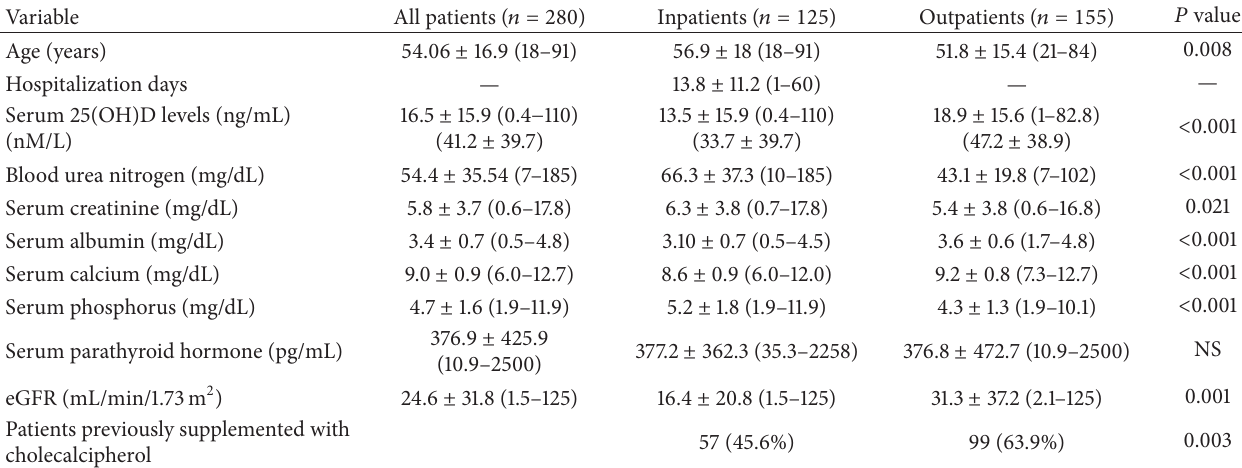
Table 2: Demographic and laboratory results of the inpatients and outpatients.